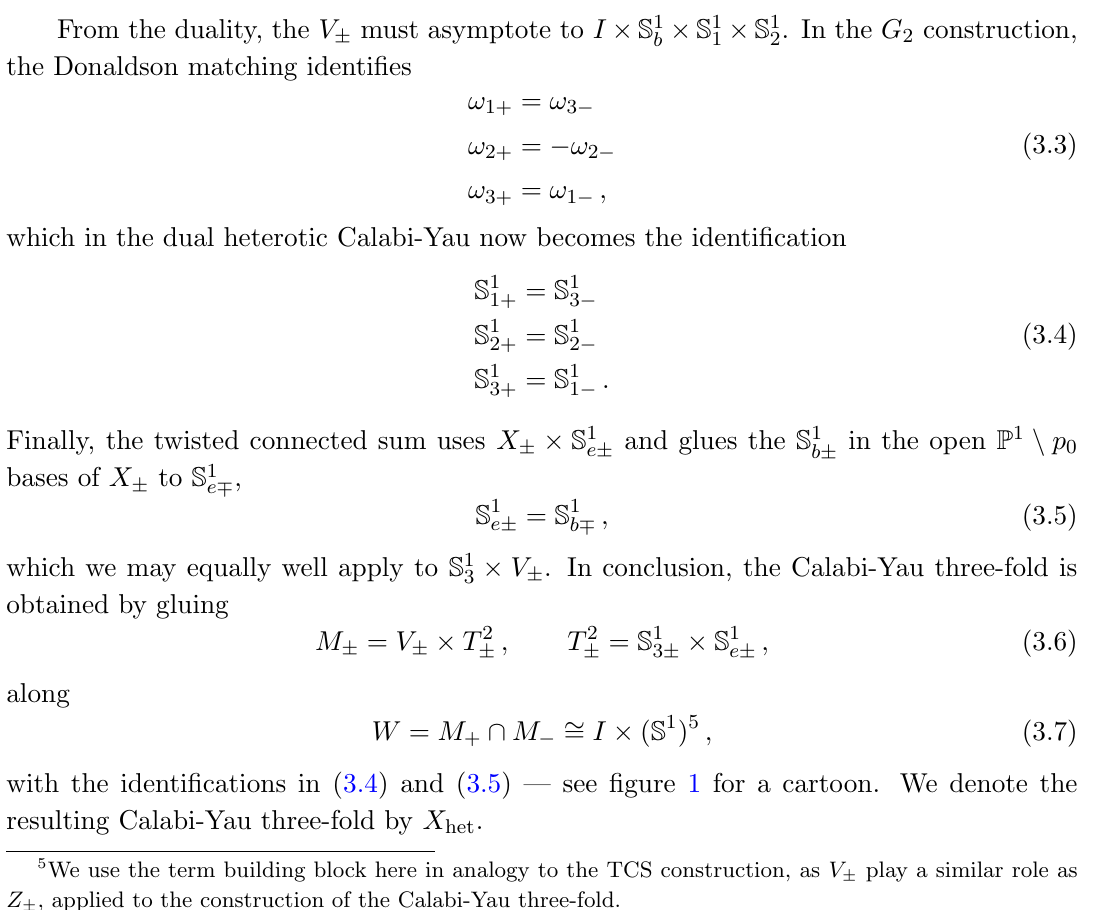
Figure 1 . A cartoon of the Calabi-Yau three-fold X het = X 19 ; 19 glued from two copies of V (cid:6) (cid:2) T 2 where T 2 = S 1 (cid:2) S 1 . The elliptic (cid:12)ber of V degenerates over 12 points of the open P 1 (cid:6) e 3